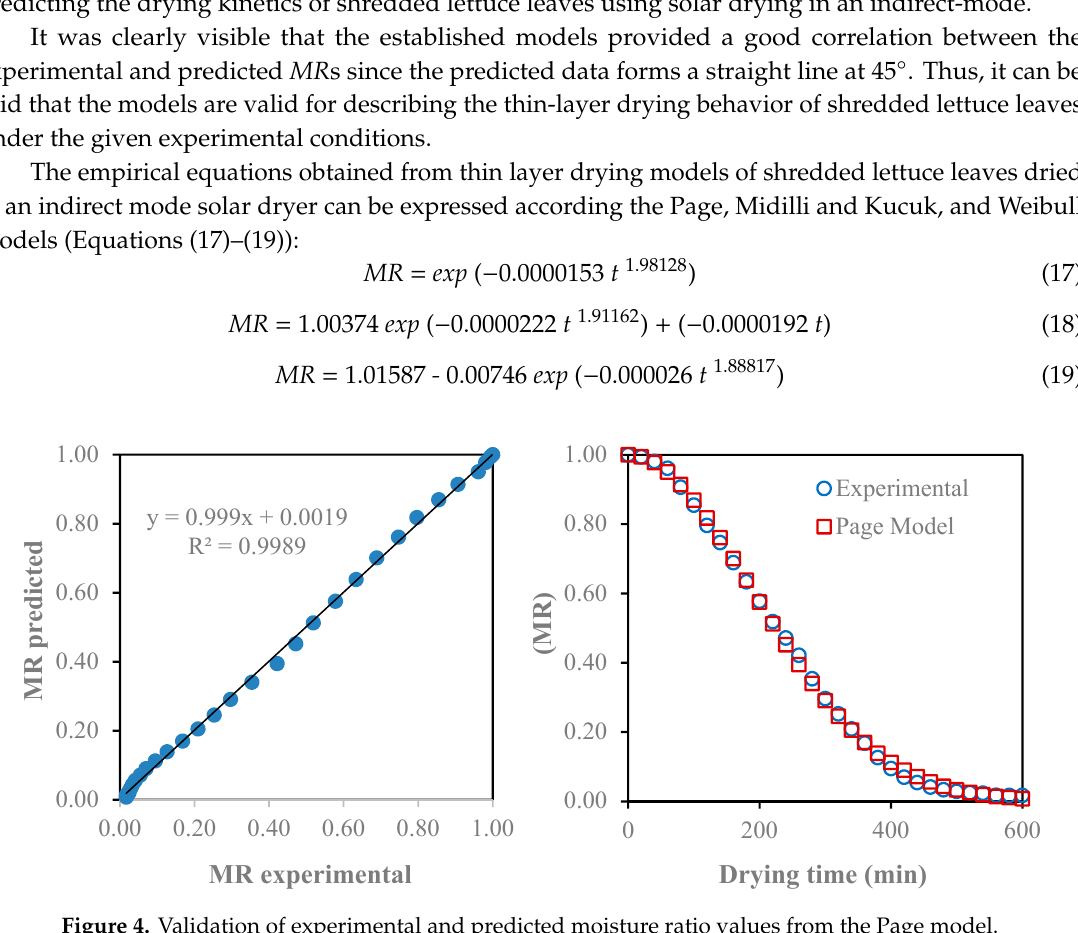
y = 0.998x + 0.001 R² = 0.9988